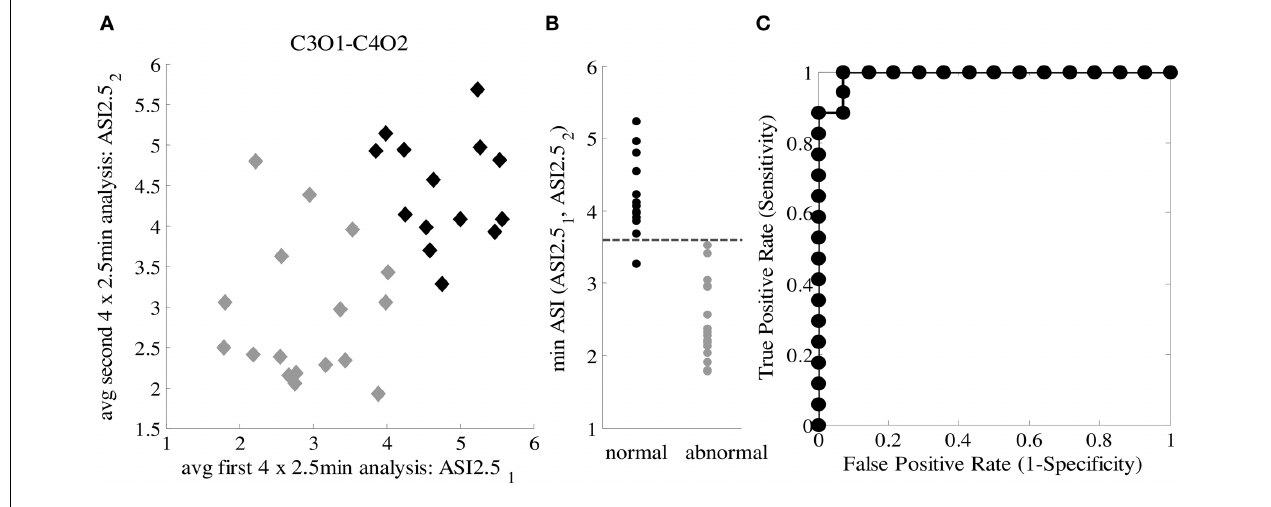
FIGURE 4 | (A) ASI2.5 1 and ASI2.5 2 for both 10-min EEG segments from 31 patients for C-O derivation with the lowest MSD value. Two groups are specified: normal patients (black labels) and abnormal patients (gray labels).